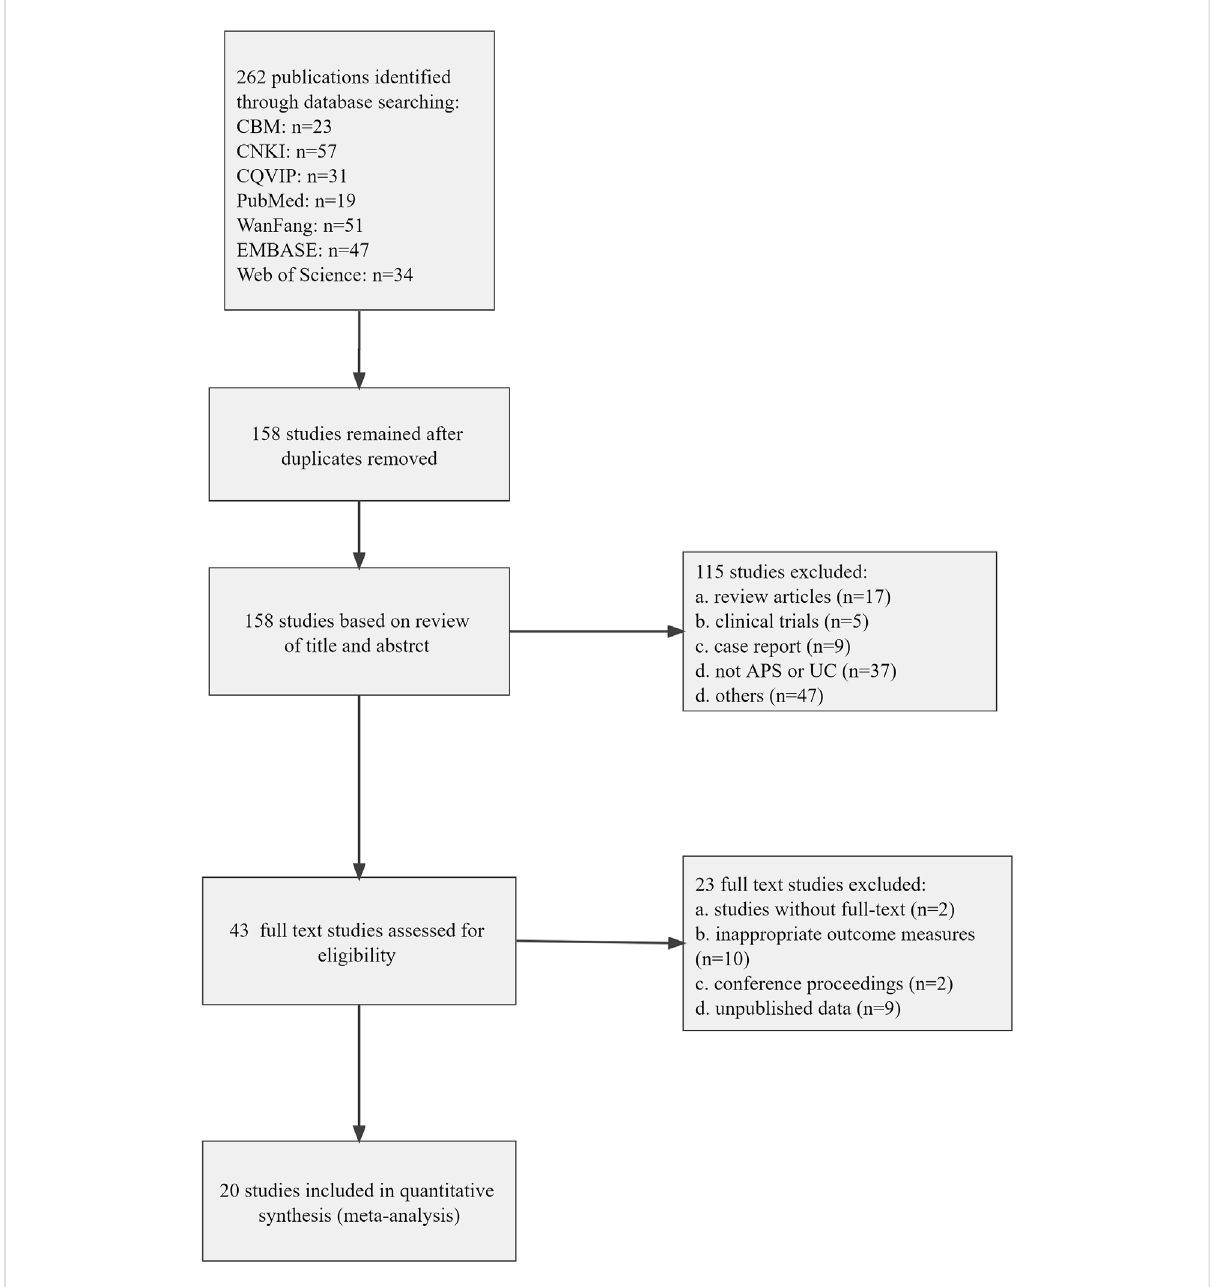
FIGURE 1 Flow diagram of the study selection process for this